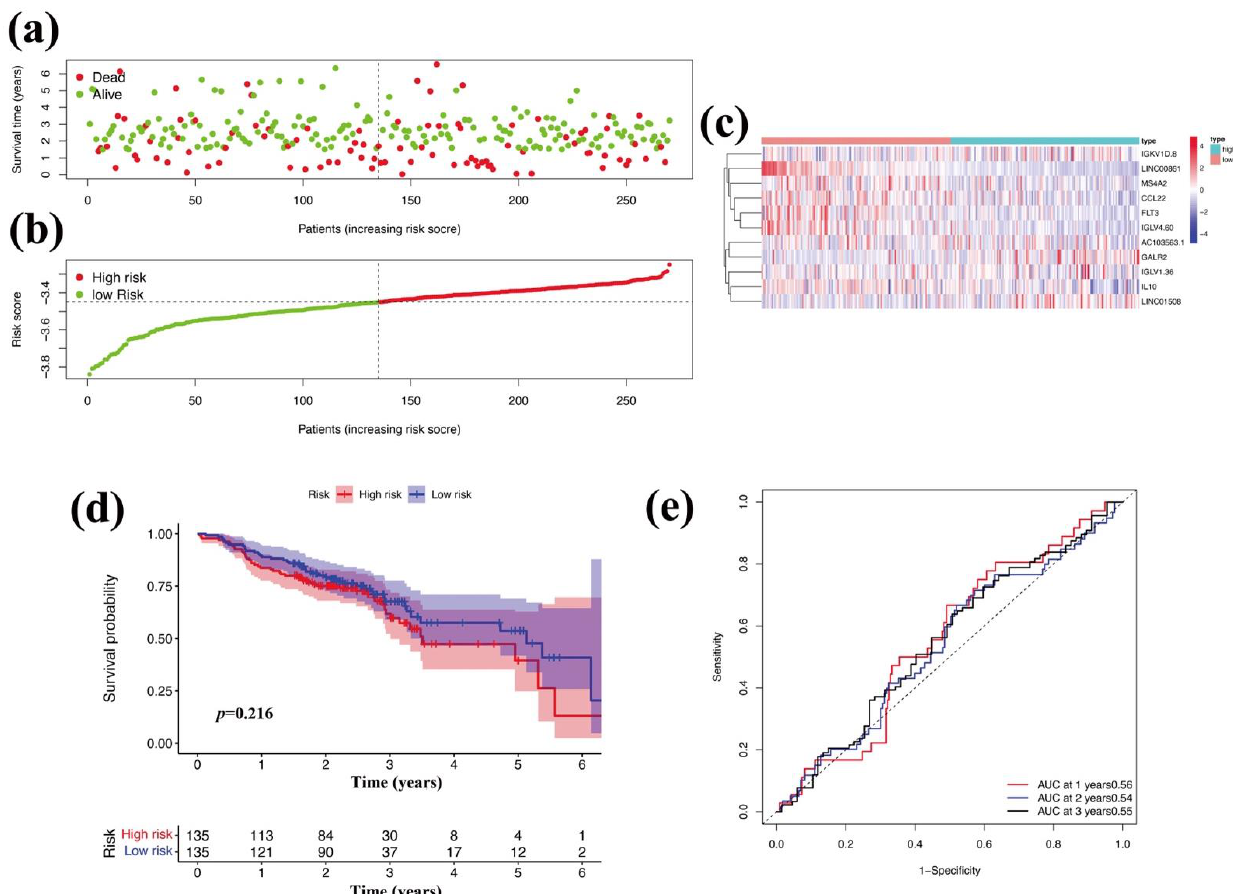
Figure 9. Validation of the 11-gene signature in the GEO cohort (GSE65858). The overall survival status ( a ), risk scores ( b ), the heatmap of the 11-gene expression pattern ( c ), Kaplan-Meier curve analysis with risk scores ( d ), and ROC curve ( e ) are shown.